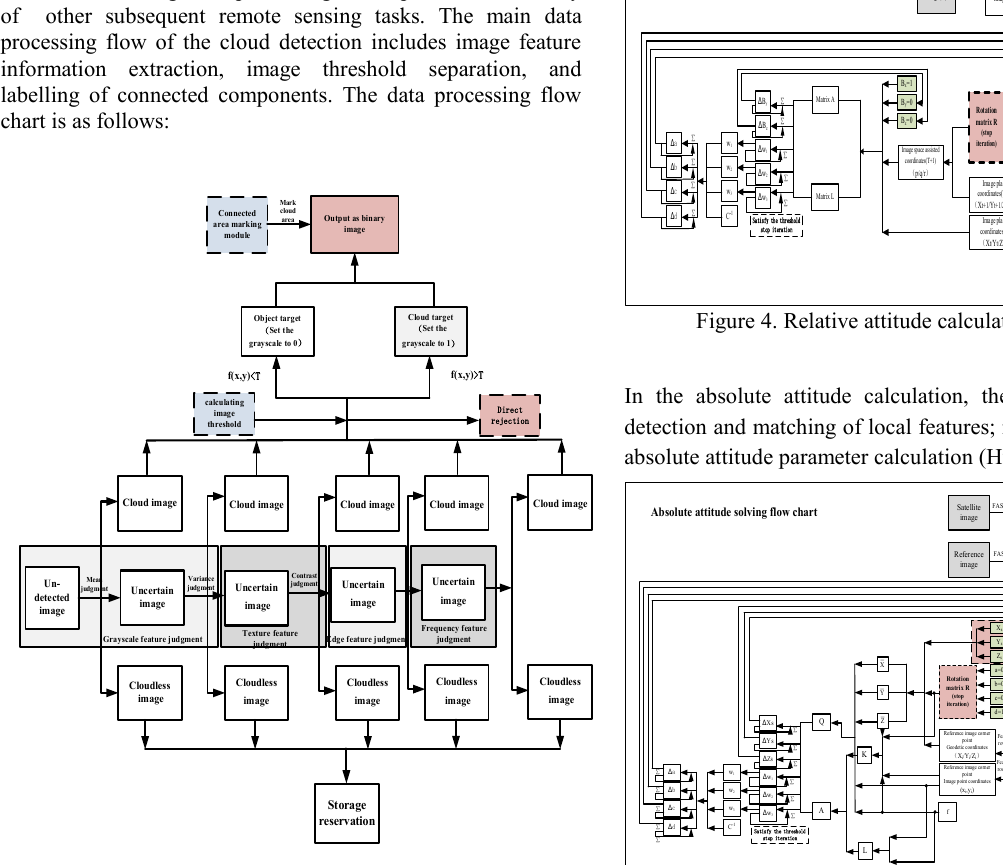
Figure 5. Absolute attitude calculation flow